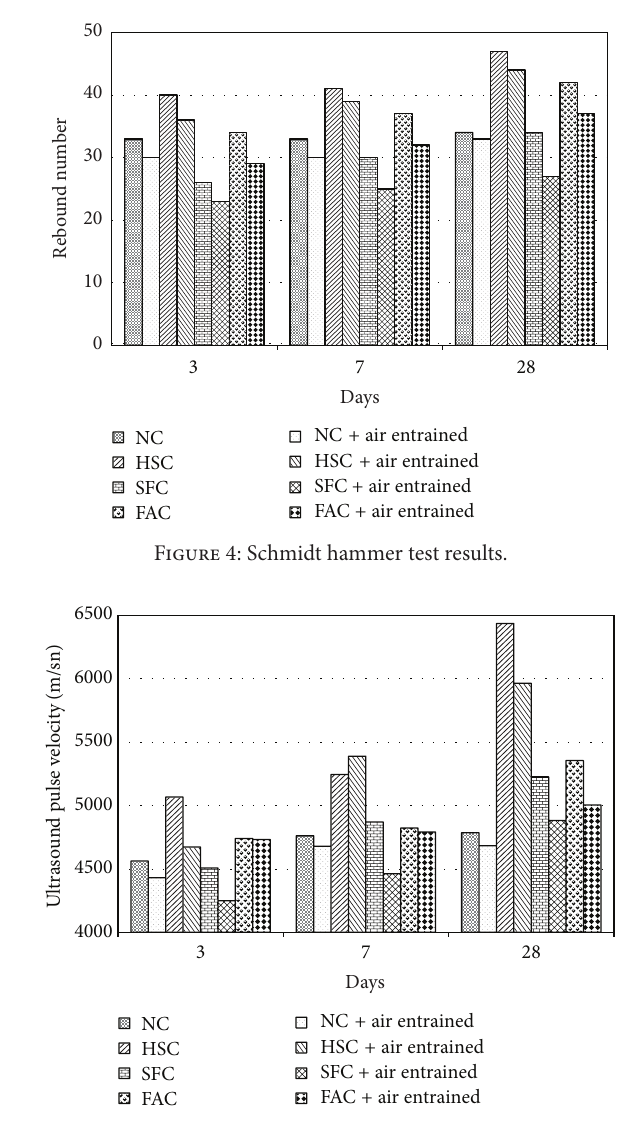
Figure 5: Ultrasound pulse velocity test